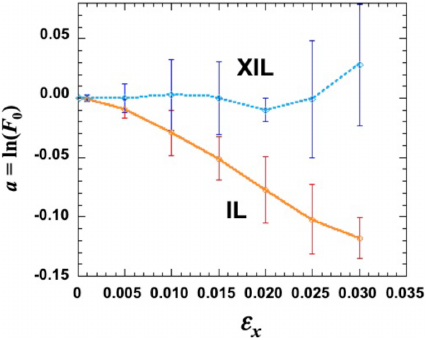
Figure 5. Retrieved values of a = ln (F 0 ) from IL and XIL methods with 10 ensemble runs of an idealized experiment ( n = 20 and m = 1 . 3 to 3.5) as a function of normal random error ε x in x . True values are assumed to be F 0 = 1; ω = 1; and τ = 0 . 1.